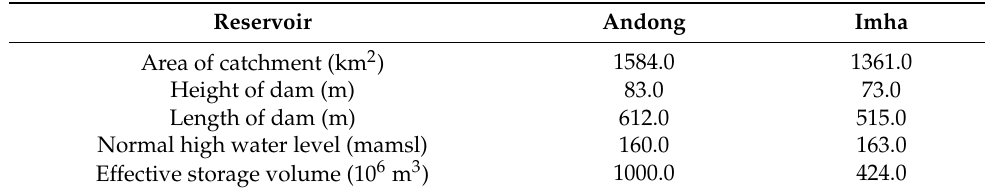
Table 1. Details about Andong and Imha